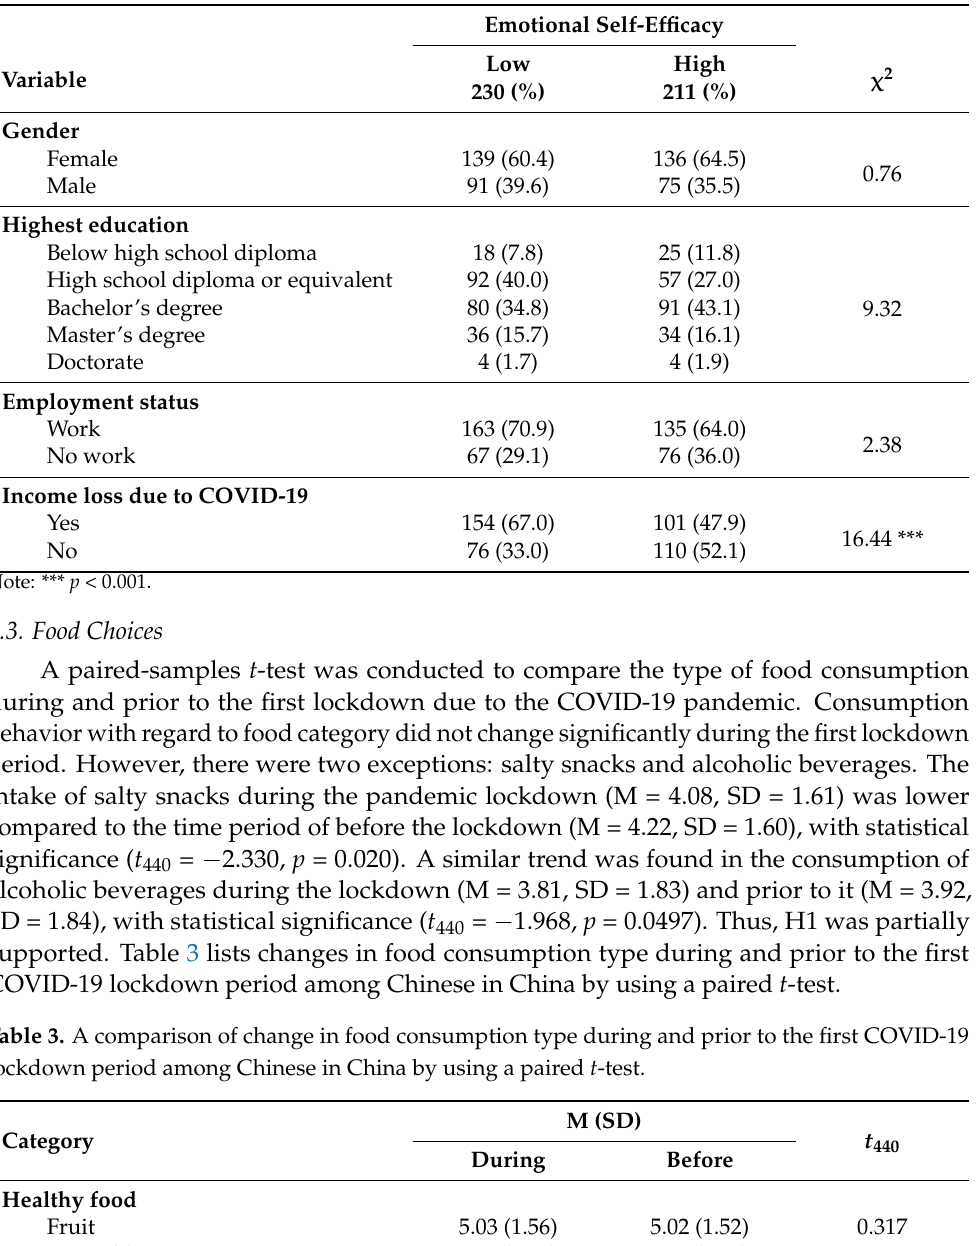
Table 2. A comparison of sociodemographic characteristics with low and high emotional self-efficacy for Chinese respondents.